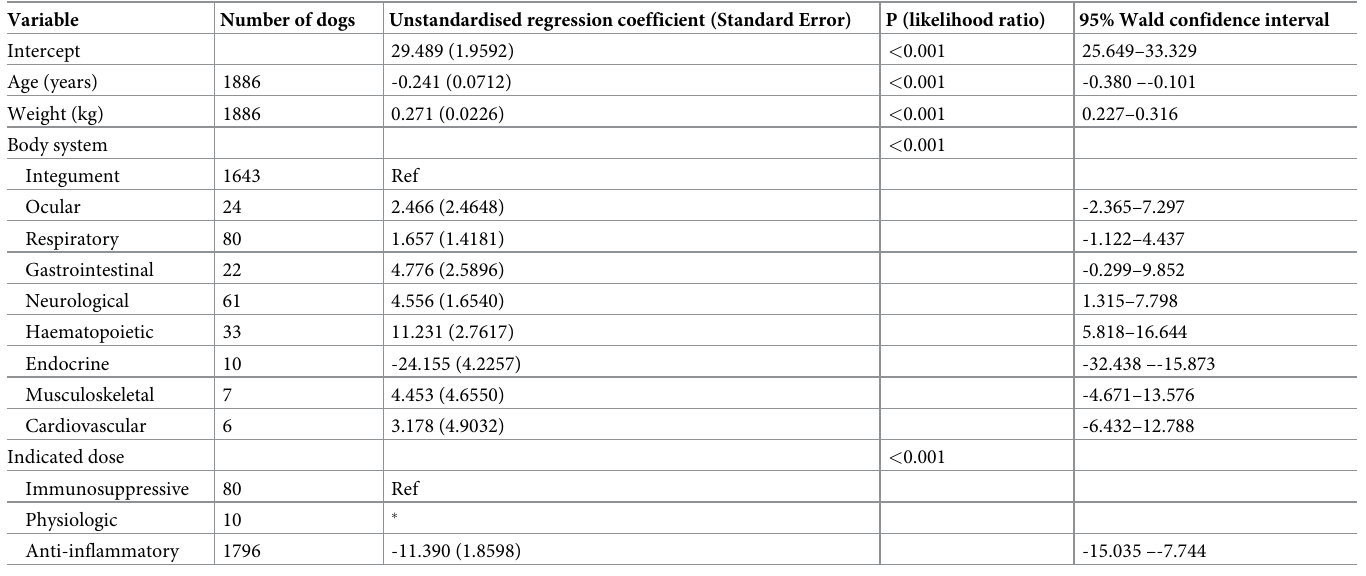
Table 7. Multivariable analysis for variables associated with prednisolone dose in mg/m 2 .